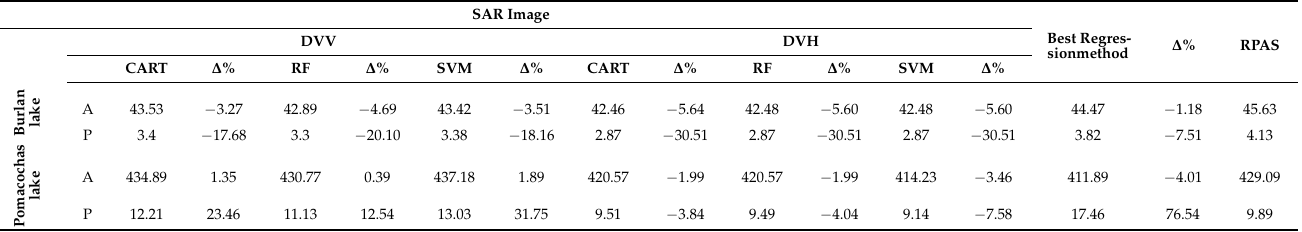
Table 4. Cross comparison of area and perimeter of SAR classification, the method of regression of higher R 2 with respect to photogrammetric flight.